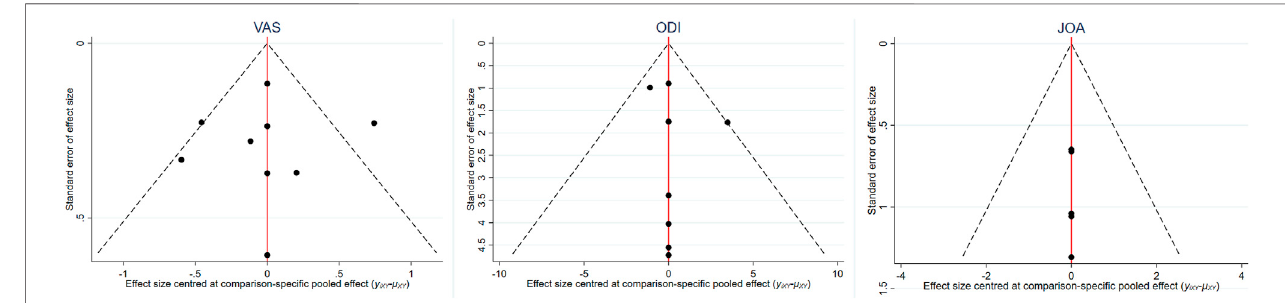
FIGURE 10 | Inverted funnel chart on VAS, ODI, and